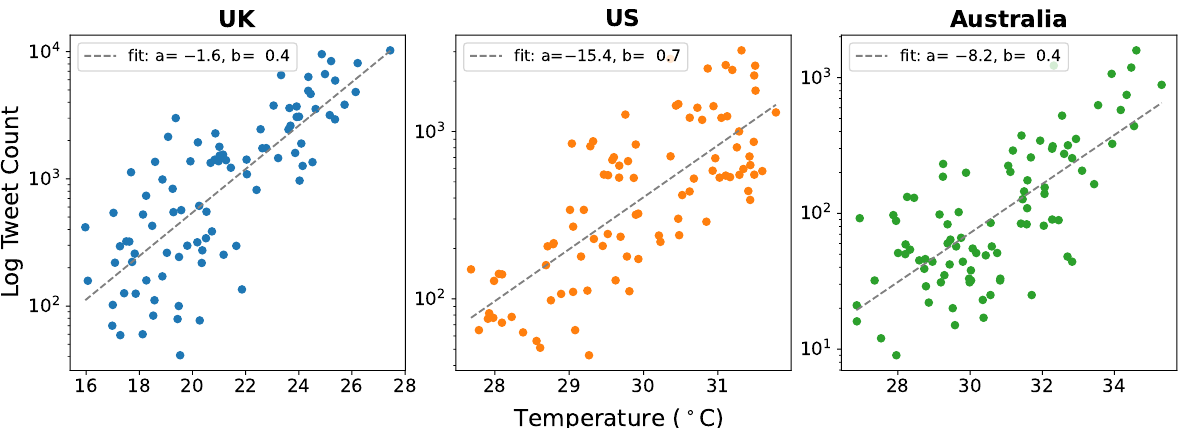
Figure 2. Scatter plot comparing the log daily tweet count to the average daily maximum temperature (ADMT) for each country. The line of best fit is modelled by log(y) = a +